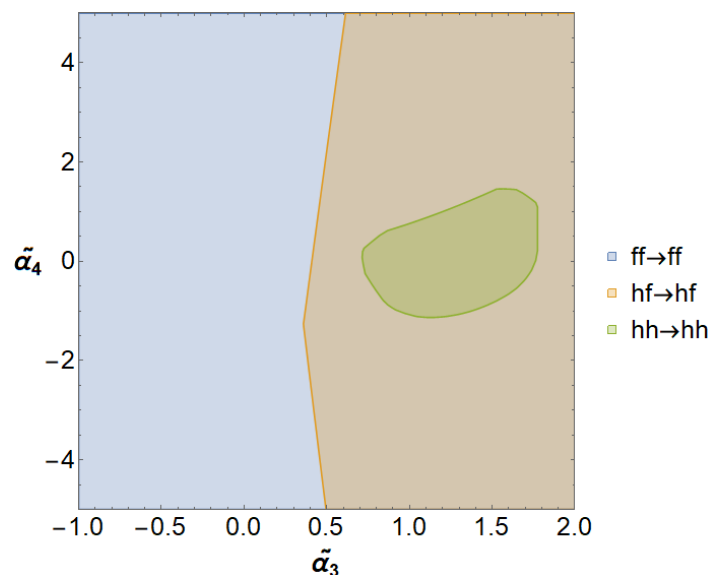
Figure 10 . The allowed regions in the (~ (cid:11) 3 ; ~ (cid:11) 4 ) plane in the case of ~ (cid:12) 3 = (cid:0) 1 ; ~ (cid:12) 4 = 0 for the mass ratios ~ x = 2 : 2 ; (cid:13) = 1 (corresponding to a mixing angle (cid:18) = 0 : 1). For these (generic) allowed values of (~ (cid:12) 3 ; ~ (cid:12) 4 ) the constraints on the couplings (~ (cid:11) 3 ; ~ (cid:11) 4 ) come mainly from the hh ! hh